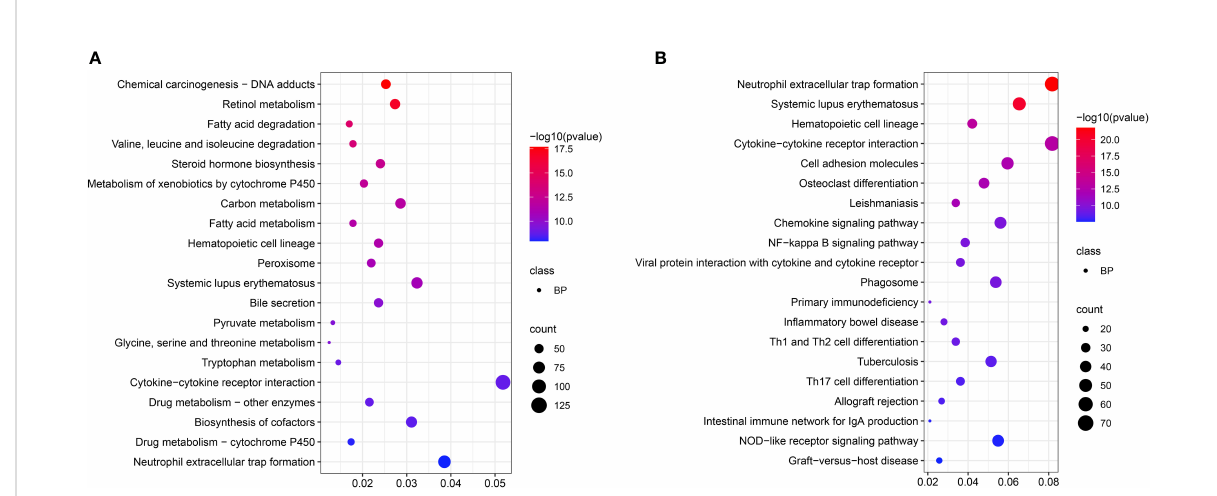
FIGURE 4 Scatter plots showing KEGG pathway of the target genes. The top 20 enriched pathways at acute infection (A) and chronic infection (B) stages, respectively. The vertical-axis represent pathways, and the horizontal-axis numbers represent the rich